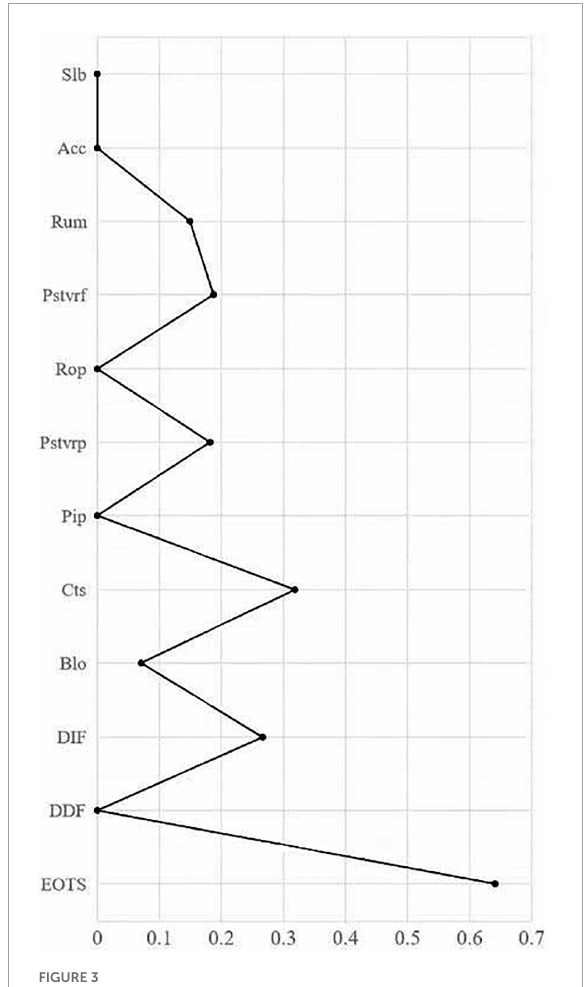
FIGURE3 Bridge Expected Influence (1-step). Slb, Self-blame; Acc, Acceptance; Rum, Rumination; Pstvrf, Positive refocusing; Rop, Refocusing on planning; Pstvrp, Positive reappraisal; Pip, putting into perspective; Cts, Catastrophizing; Blo, Blaming others; DIF, Difficulty Identifying; DDF, Difficulty Describing Feelings; EOTS, Externally-Oriented